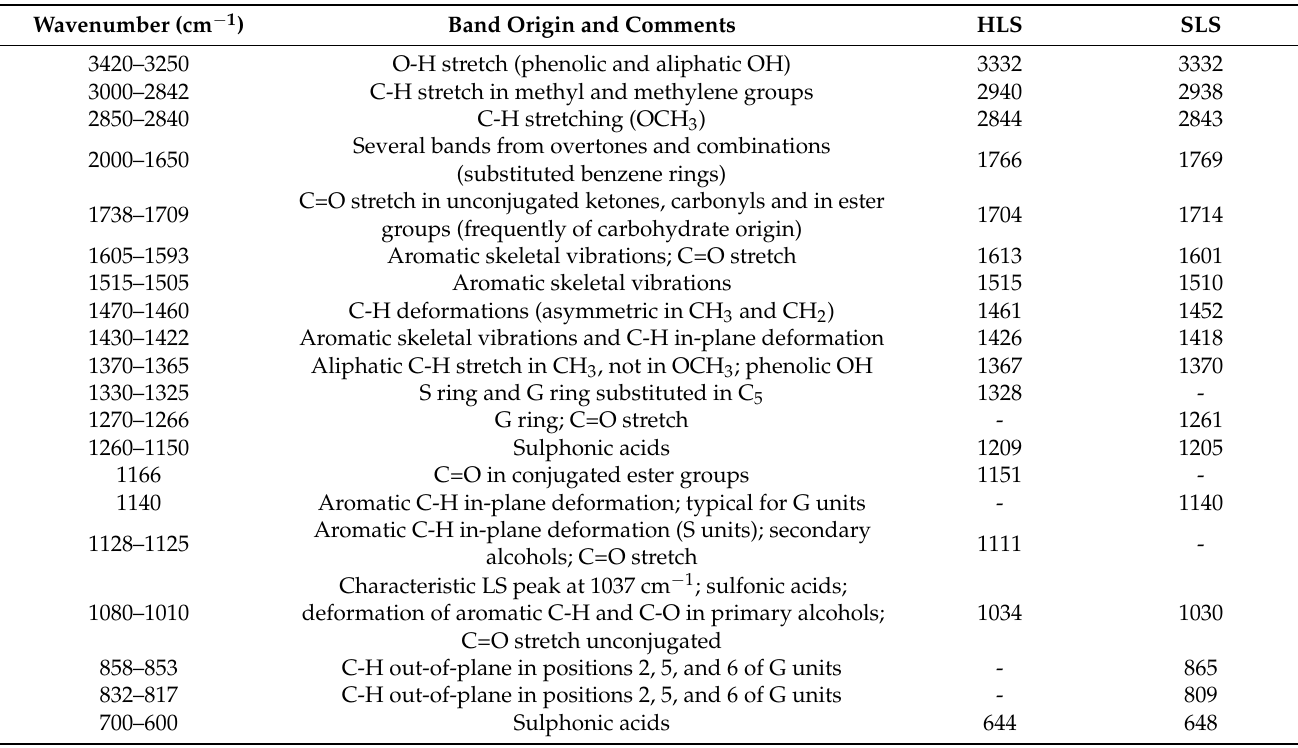
Table 3. FTIR absorption band assignments of the SLS and HLS samples [34,49,52–54].